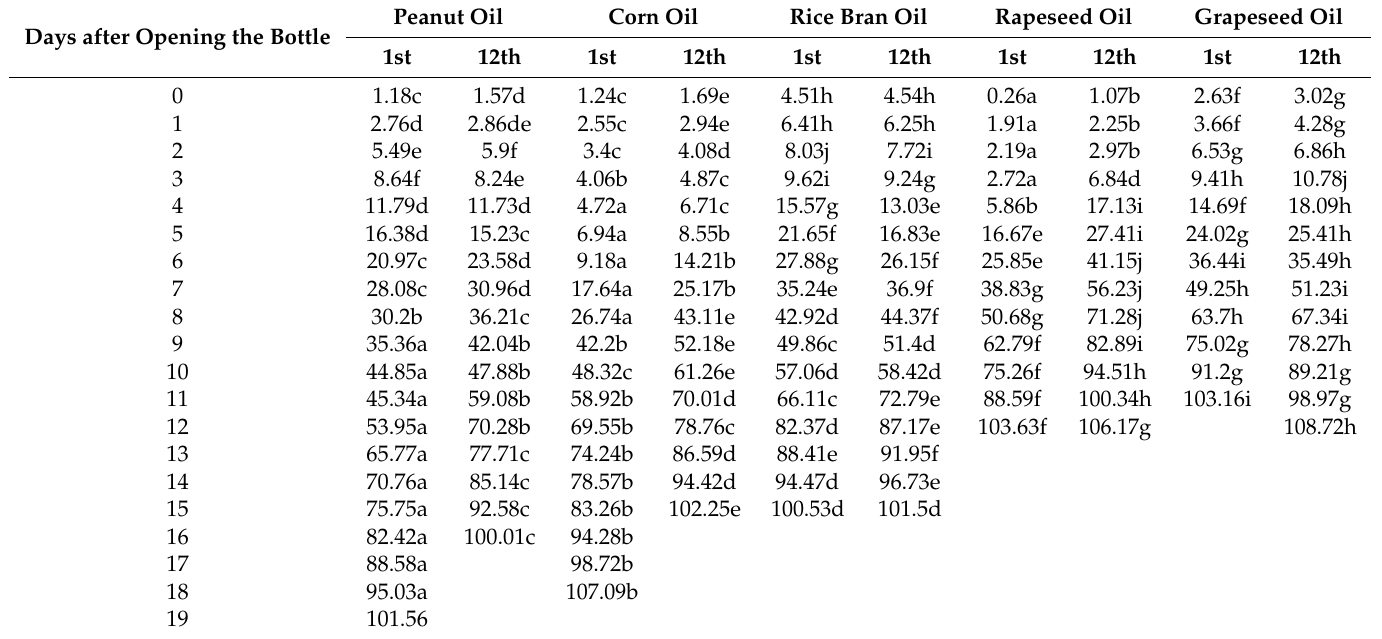
Table 2. PV changes of the selected oils in the Schaal Oven Test at 1st and 12th months of storage.